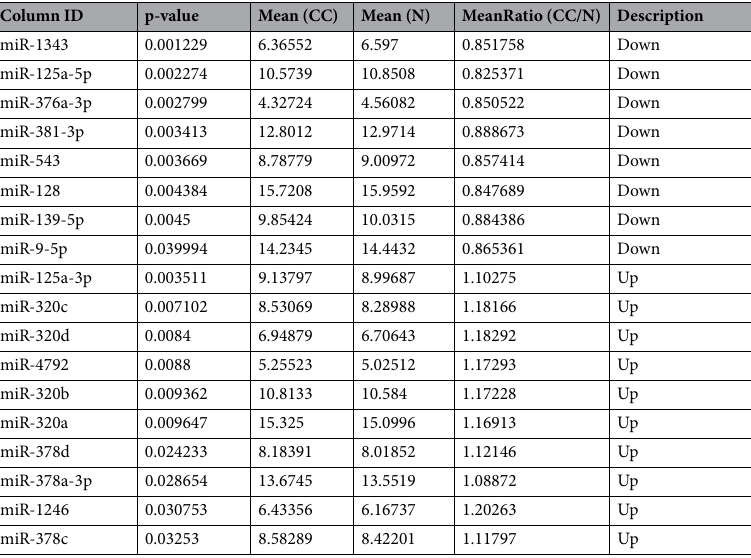
Table 1. Early stage colon cancer relevant miRNA markers (Stage I and Stage II compared with normal controls). CC = Colon Cancer; N = Normal